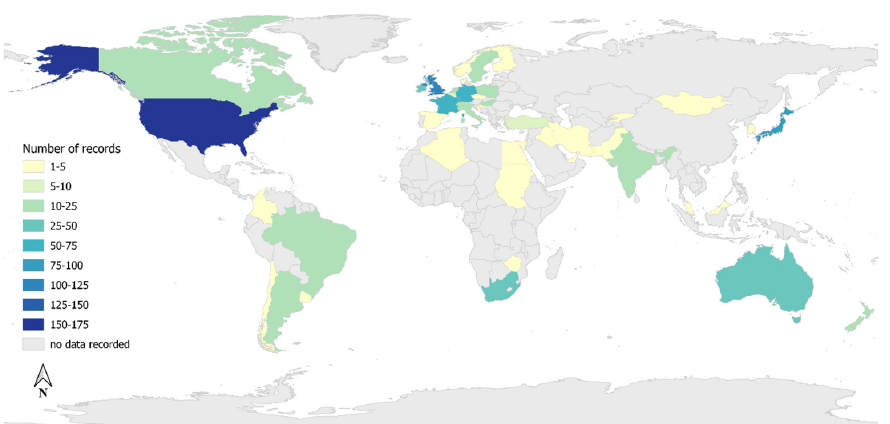
Figure 3. Location of data collected from the 446 records captured from a scoping review on the reported causes and syndromes associated with mid to late-term pregnancy loss in horses.